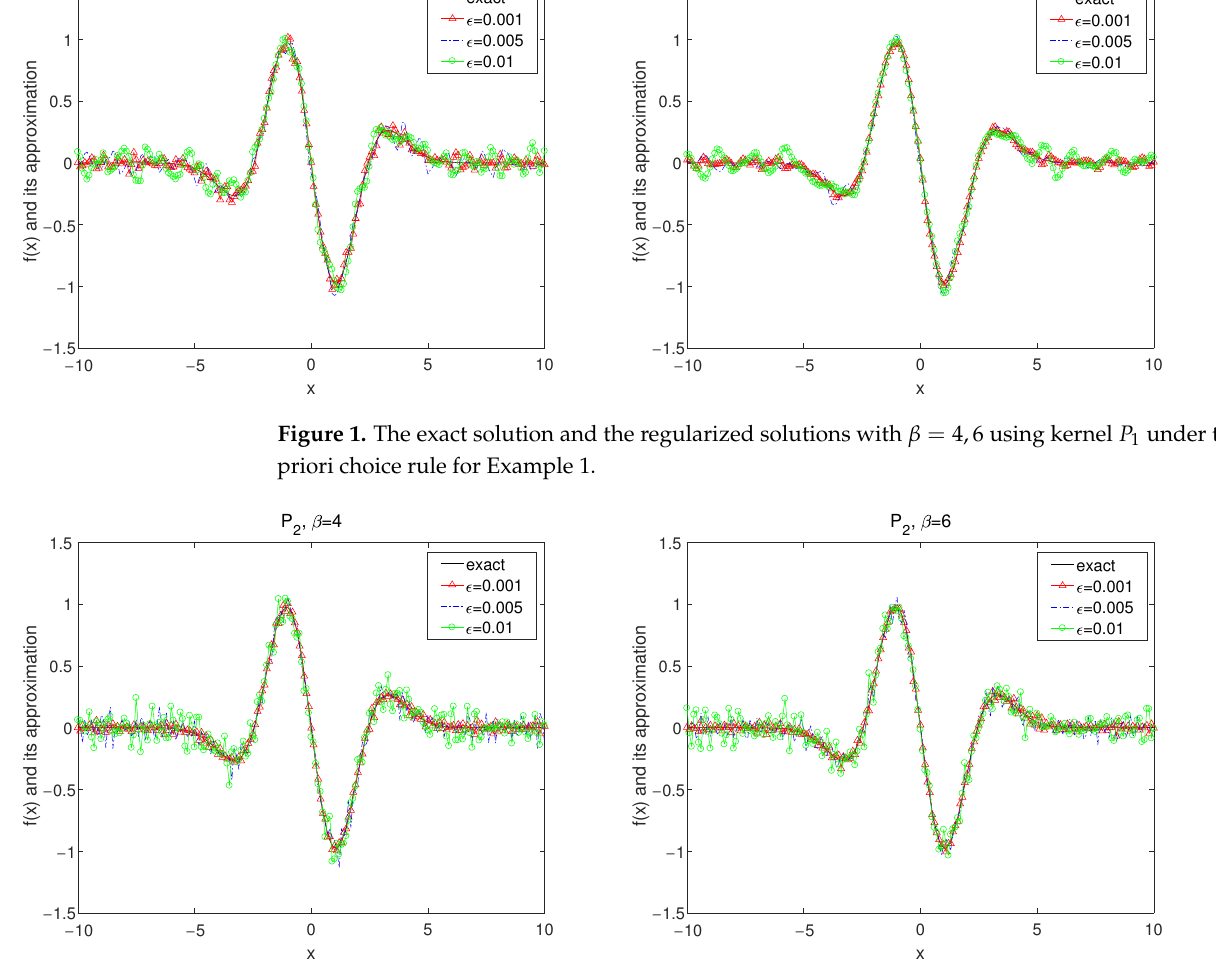
Figure 2. The exact solution and the regularized solutions with β = 4,6 using kernel P 2 under the a priori choice rule for Example